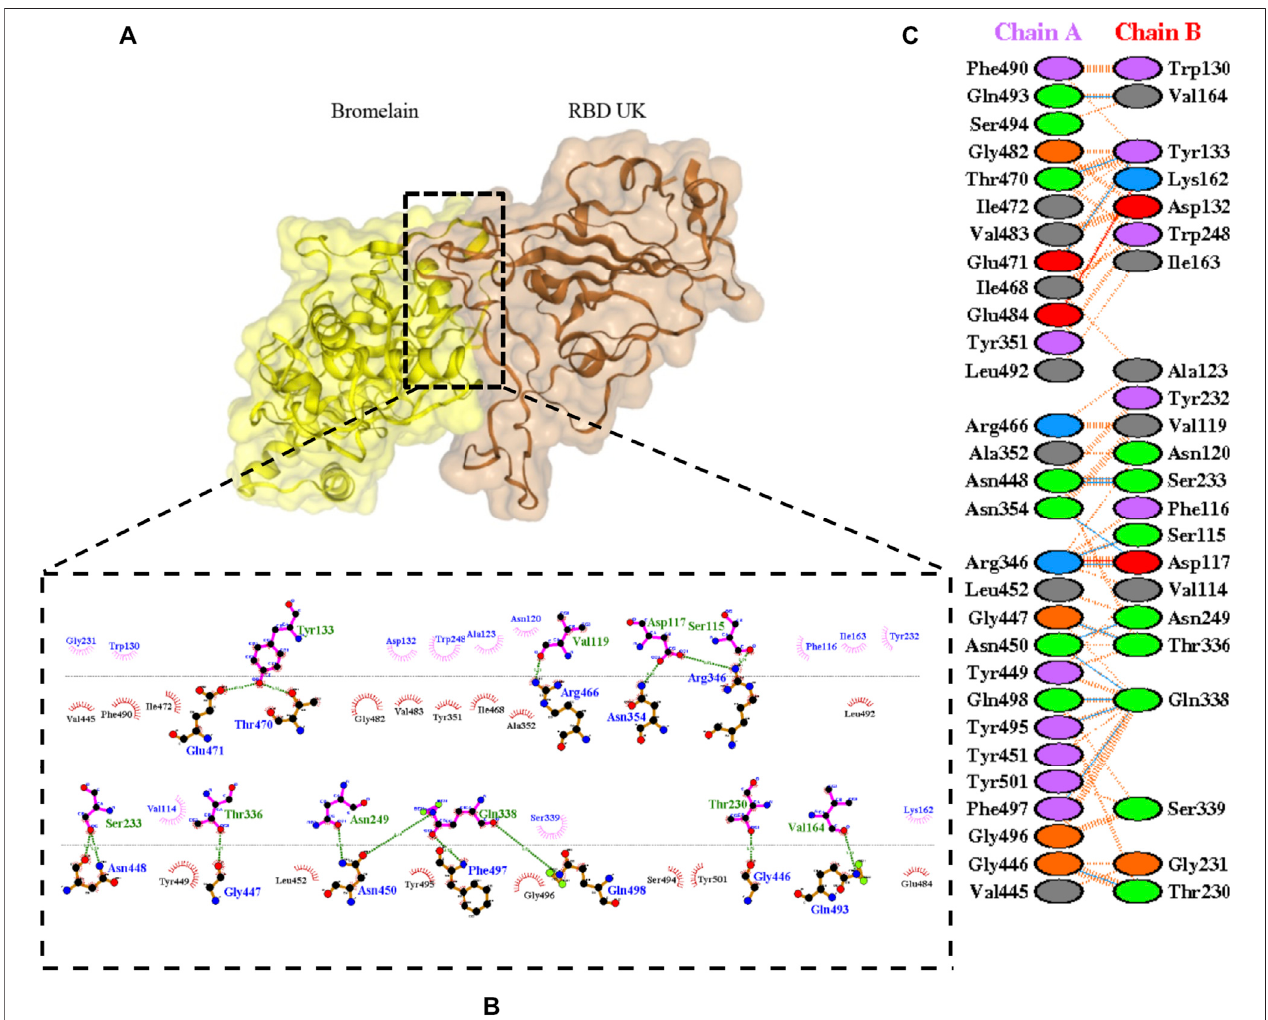
FIGURE 7 | Docking representation of the United Kingdom variant and bromelain complex. (A) the binding interface of the complex, (B) the binding interaction betweentheaminoacids,and (C) interactionrepresentationincludinghydrogen,saltbridges,andnonbondedinteractions.ChainAisRBDUnitedKingdomandchainB is